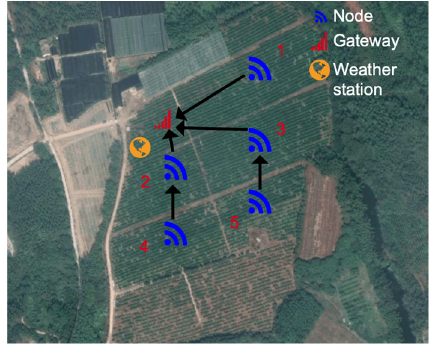
Figure 4. Tree topology of ZigBee network in citrus orchard.